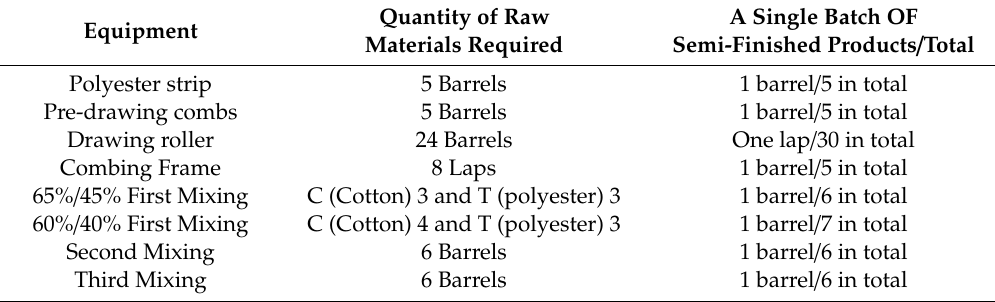
Table 7. Equipment processing batch